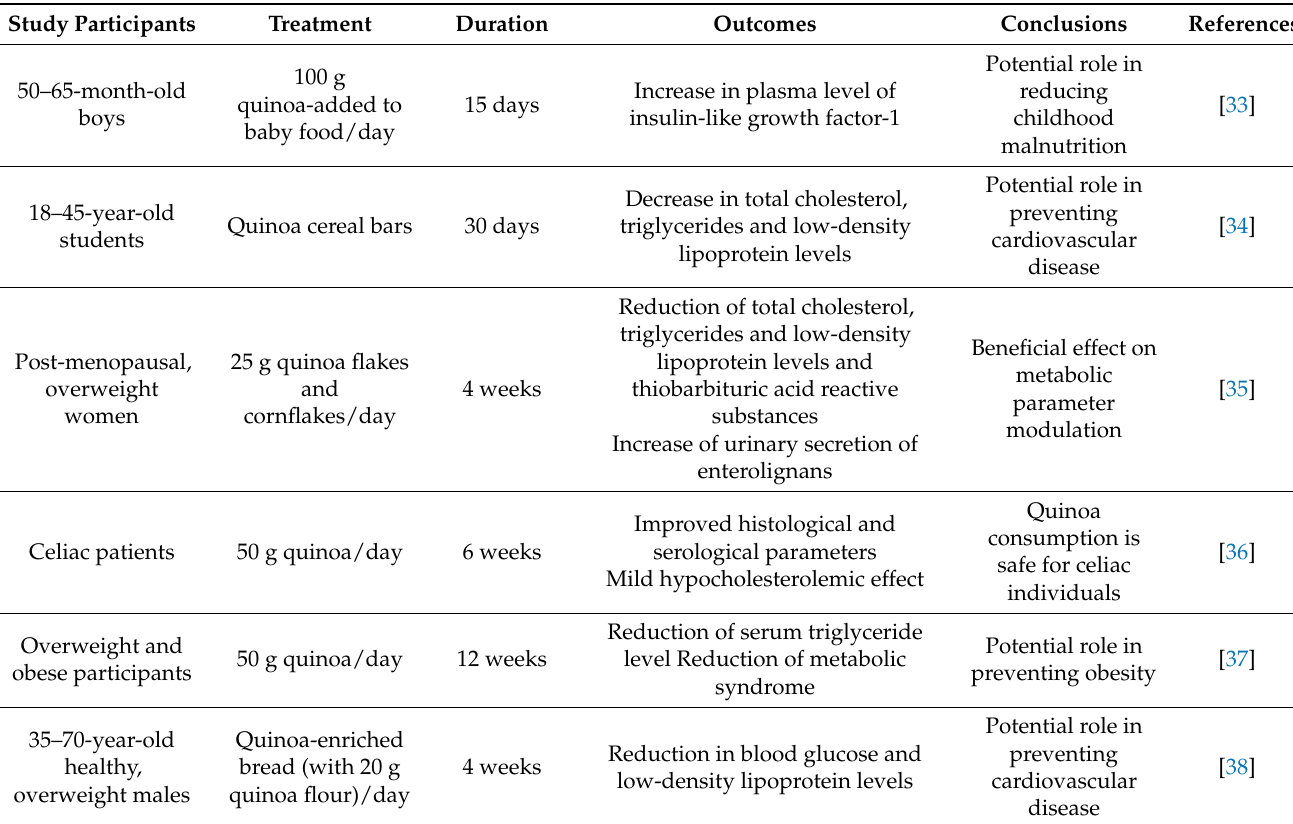
Table 1. The effect of quinoa products in human